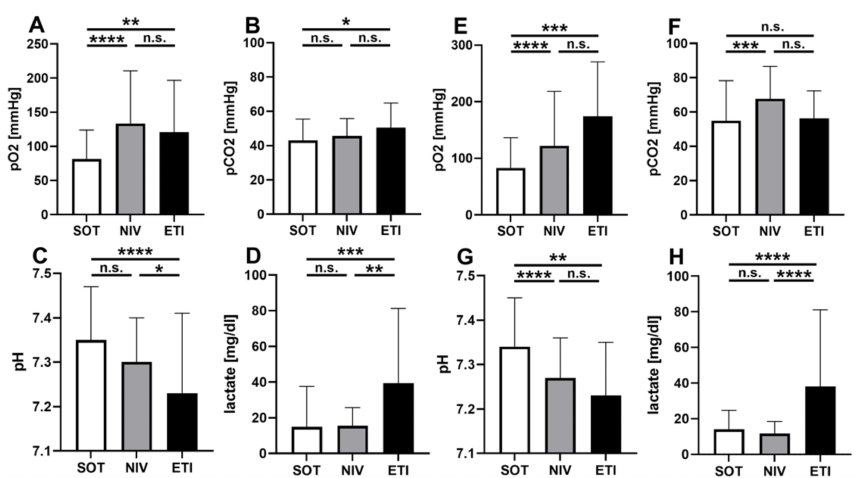
Figure 4. First blood gas analysis after hospital admission by underlying pathology. Arterial or capil- lary blood gas analysis after hospital admission from ACPE ( A – D ) and AECOPD ( E – H ) subgroups. ( A , E ): oxygenation stated as pO 2 = partial pressure of oxygen; ( B , F ): elimination of CO 2 stated as pCO 2 = partial pressure of carbon dioxide; ( C , G ): acid-base status stated as pH value; ( D , H ): plasma lactate levels. Data are plotted as mean and standard deviation; p > 0.05 = not significant (n.s.), p < 0.05 = *, p < 0.01 = **, p < 0.001 = *** p < 0.0001 = ****. Abbreviations: SOT = standard oxygen therapy, NIV = non-invasive ventilation, ETI = endotracheal